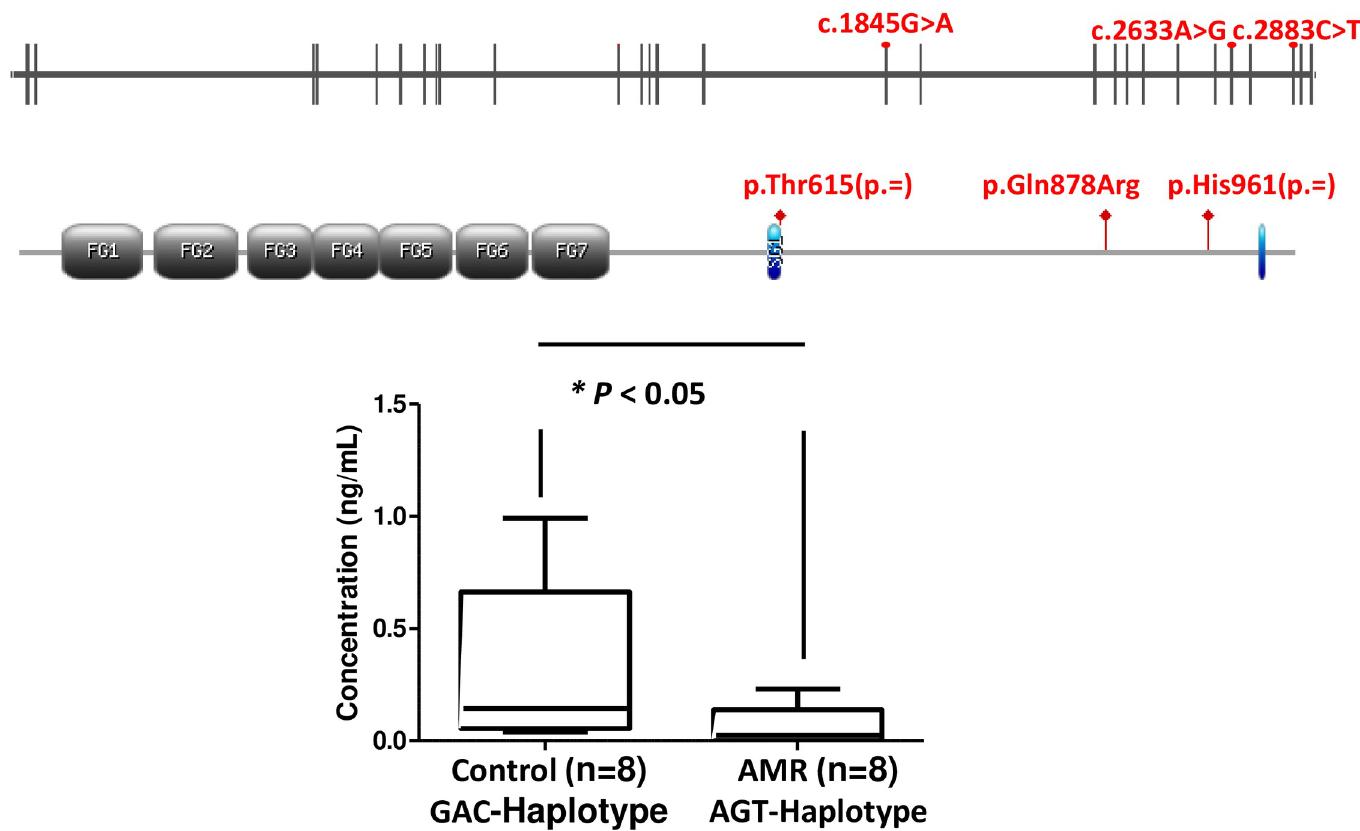
Fig 2. ITGA4 gene. Schematic structure of the human ITGA4 gene and primary protein domains of ITGA4 showing relative position of the 3 common polymorphism found (c.1845G > A), c.2633A > G), c.2883C > T). ITGA4 serum levels according to ITGA4 haplotype among 8 AMR patients (AGT) and 8 control patients (GAC).